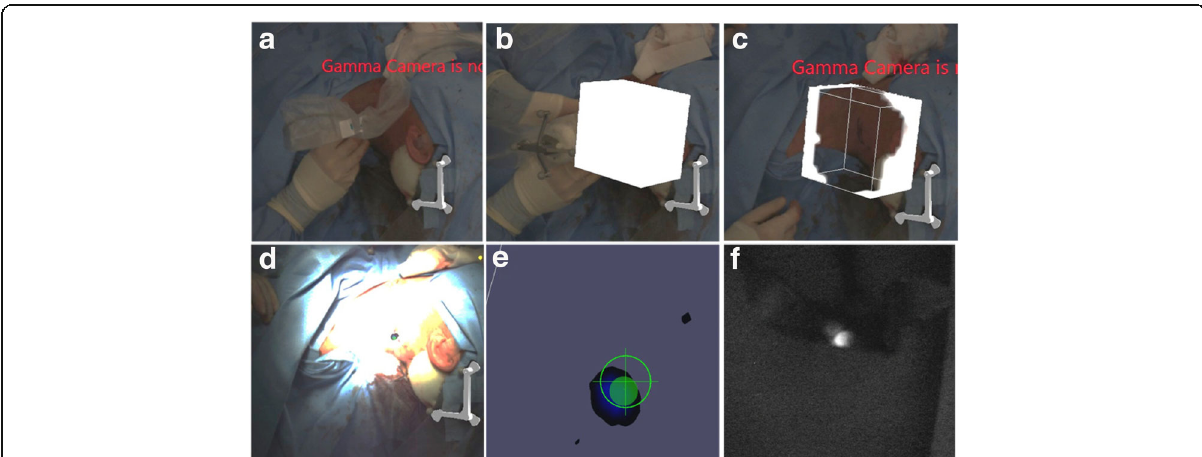
Fig. 2 Intraoperative navigation procedure. a Pre-navigation overview. b , c Intraoperative freehandSPECT acquisition. d Augmented reality following reconstruction of the acquired data wherein a 3D overlay is obtained. e Navigation of the gamma probe in 3D virtual reality. f Optical confirmation of sentinel node localization via fluorescence